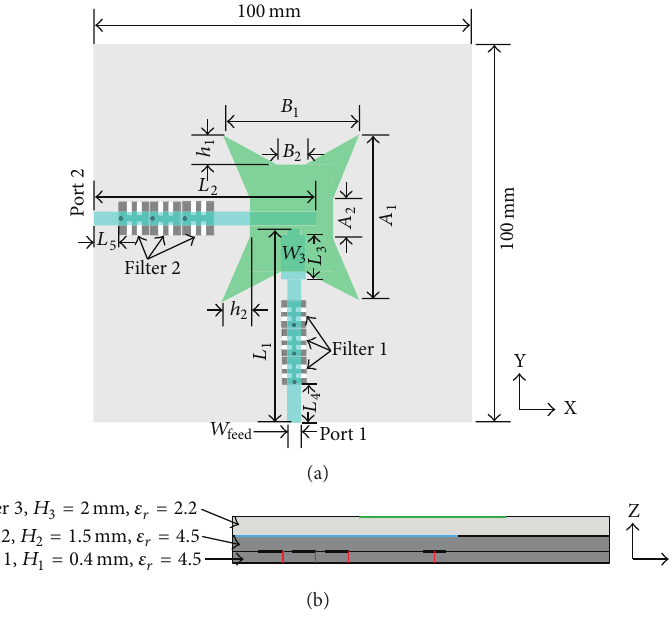
Figure 4: Configuration of the proposed antenna. (a) Top view. (b) Side